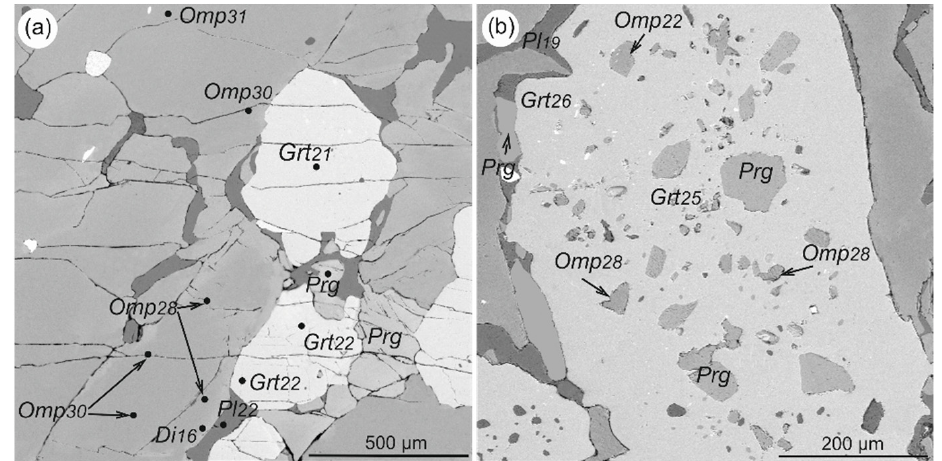
Figure 3. В ack-scattered electron (BSE) images of thin sections of eclogites from the sampling site in the massive eclogite body: ( а ) best-preserved eclogite with minor retrogression, diopside ( Di , subscript = Jd content) of a retrograde HP-granulite stage is located together with plagioclase ( Pl , subscript = An content) and pargasite ( Prg ) in a narrow marginal zone of an omphacite ( Omp , subscript = Jd content) crystal (thin section В -3 [14]); ( b ) garnet ( Grt subscript = Prp content) crystal containing abundant inclusions of Omp , chlorine-bearing pargasite ( Prg ), and quartz (thin section from eclogite ST-2D).